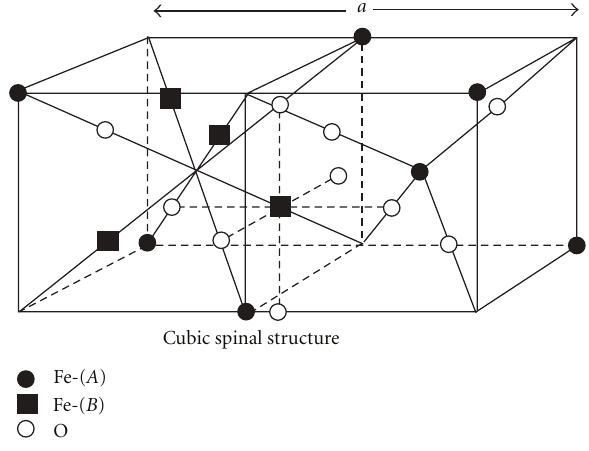
Figure 1: Crystal structure of Fe 3 O 4